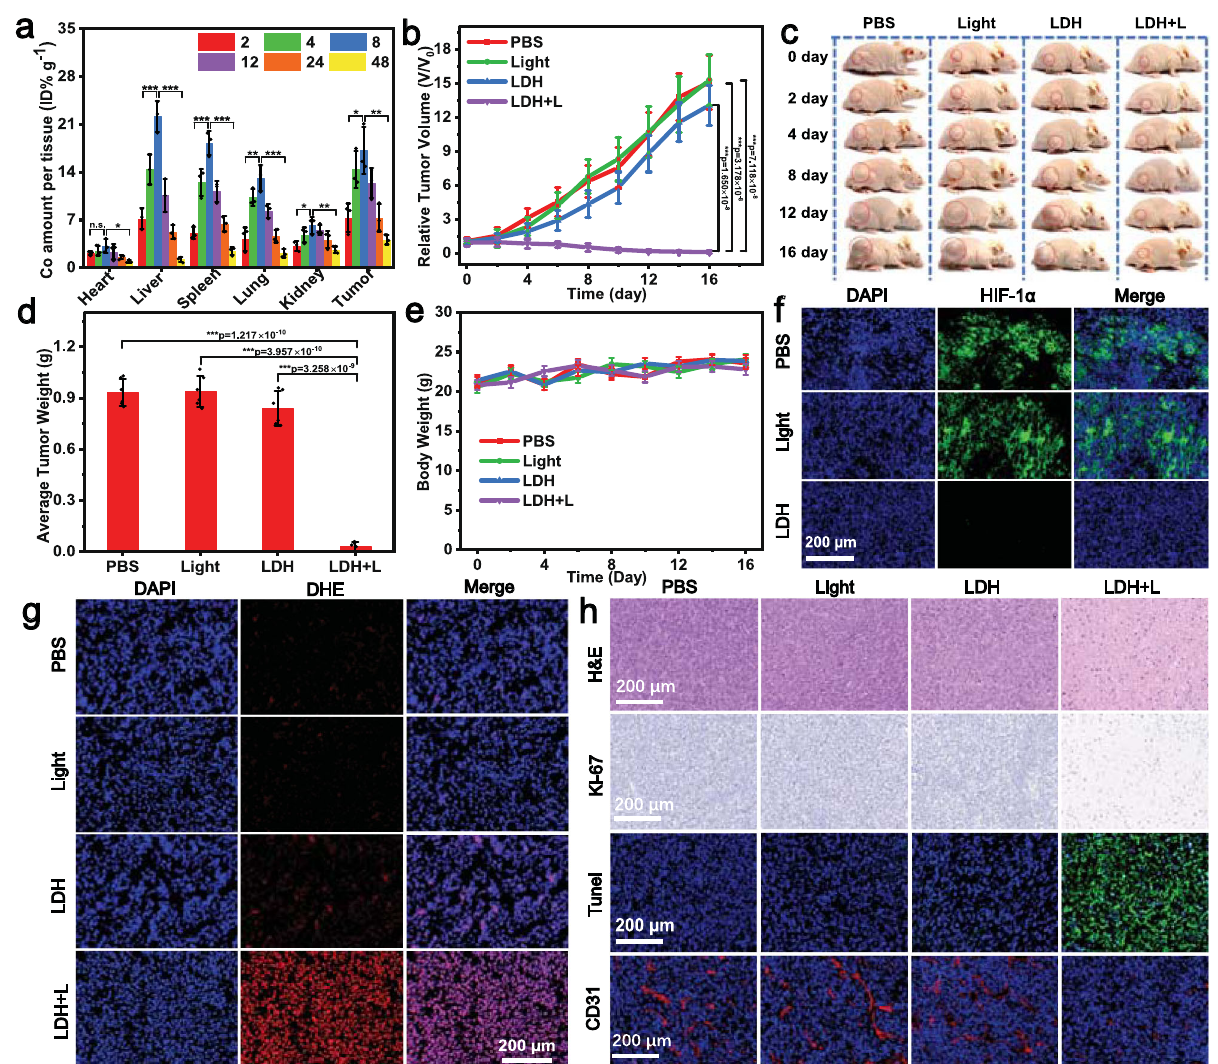
Fig. 6 In vivo PDT effects of DR-CoMo-LDH-PEG conducted on 4T1 tumor-bearing mice. a Biodistribution of DR-CoMo-LDH-PEG in mice by monitoring the Co concentration at various time points post-injection. Data are presented as mean values ± s.d. ( n = 3). Statistical analysis was performed via one-way ANOVA. *p < 0.05, **p < 0.01, ***p < 0.001. b Tumor growth curves of mice after various treatments. Data are presented as mean values ± s.d. ( n = 6). Statistical analysis was performed via one-way ANOVA. ***p < 0.001. c Representative photographs of mice with treatments at various time points and d corresponding average weight of tumors taken on Day 16. Data are presented as mean values ± s.d. ( n = 6). Statistical analysis was performed via